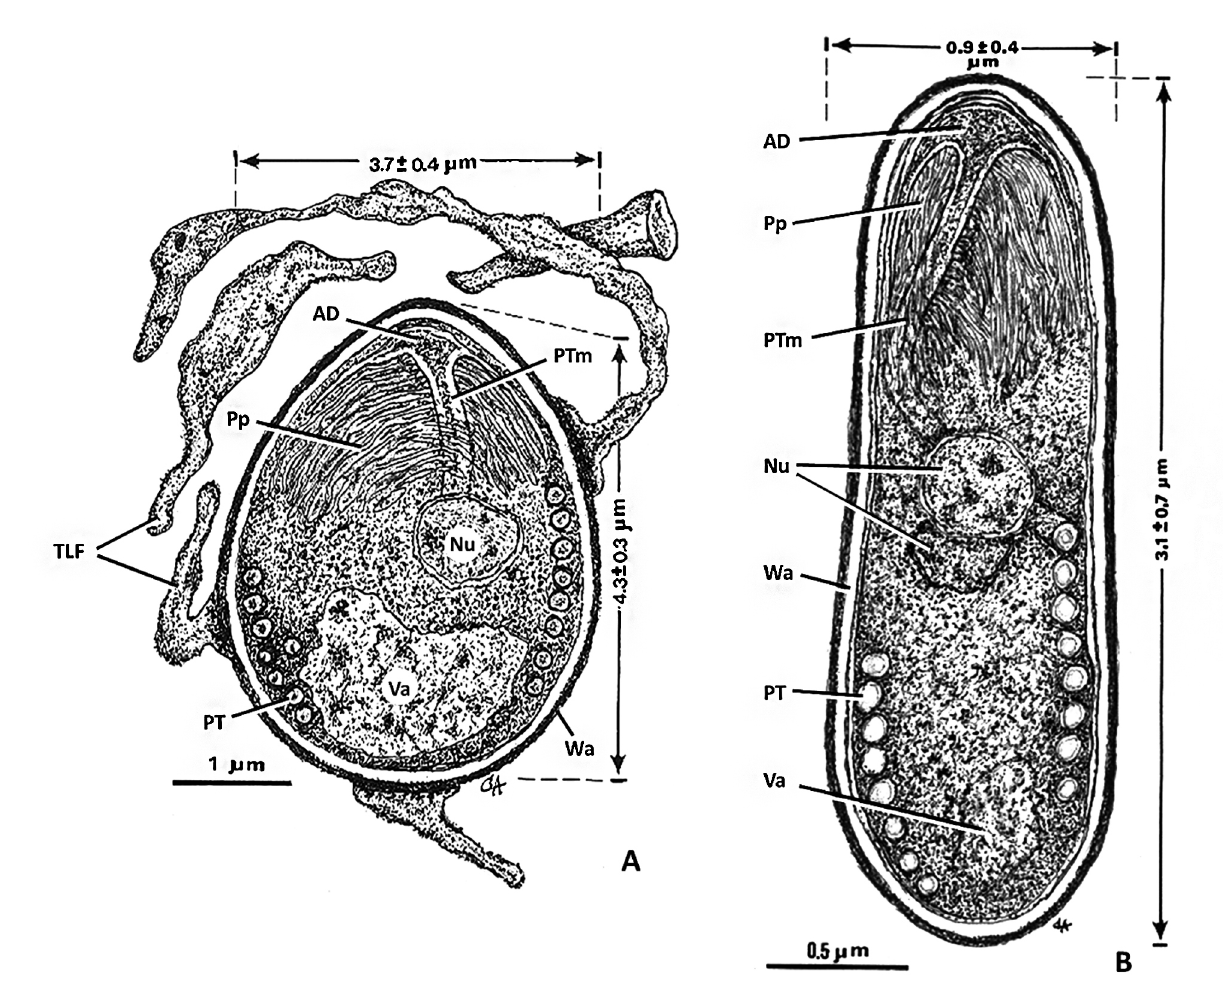
Figure 6. Schematic drawings of the studied microsporidian spores: ( A ) Inodosporus sp. and ( B ) Myospora sp. AD - anchoring disc; Nu - Nucleus; Pp - polaroplast; PT - polar tube; PTm - polar tube manubrium; TLF - tape-like filaments; Va - vacuole; Wa – wall.